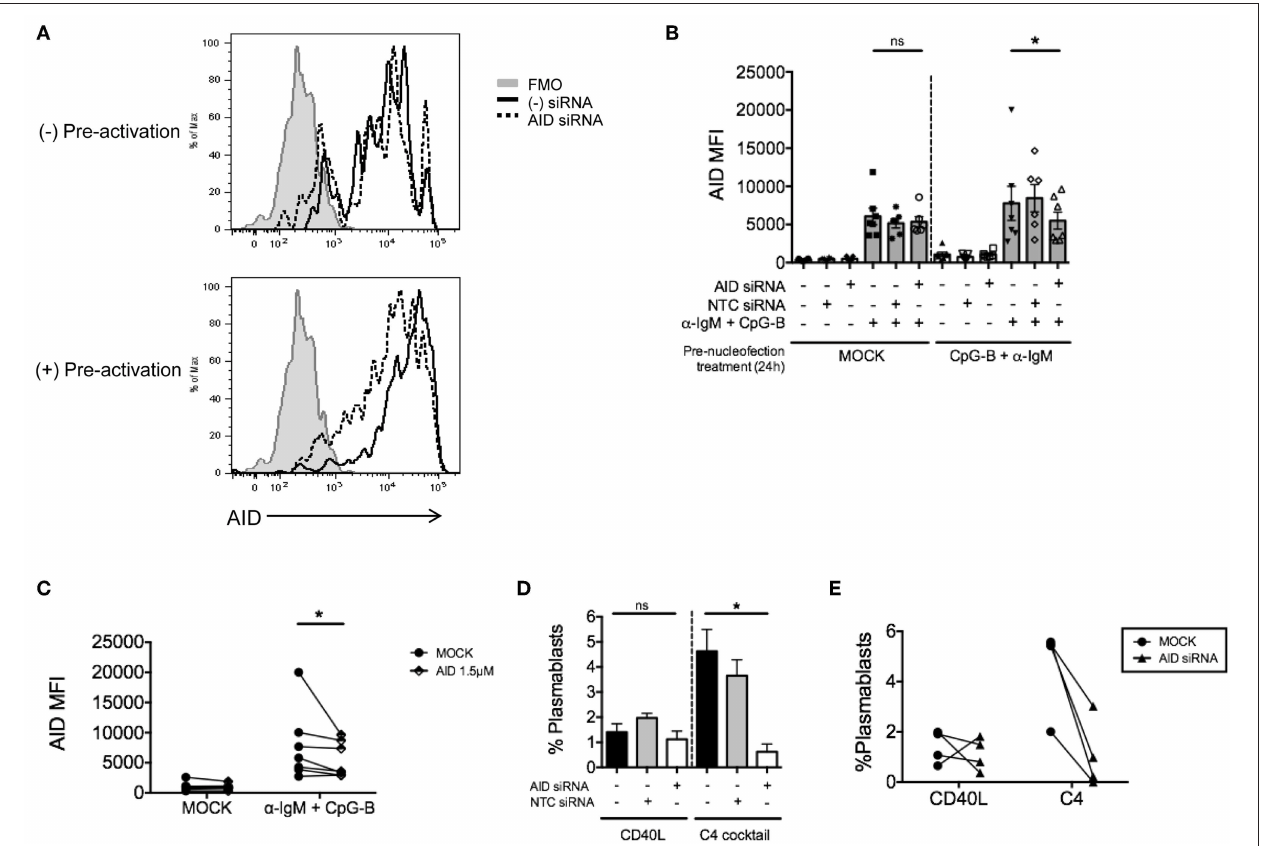
FIGURE 5 | Pre-activation of primary naïve human B cells enhances the effect of AID knockdown. Isolated naïve B cells were cultured for 24h ( + Pre-activation) or without (-Pre-activation) anti-IgM + CpG-B then nucleofected one time with AID or NTC siRNA (1.5 µ M). After 24h resting, cells were re-stimulated with or without anti-IgM + CpG-B for 72h. (A) Representative histogram overlay of AID expression after knockdown in the presence or absence of pre-activation. (B) AID MFI in CD19 + IgD + B cells was determined at 72h post-stimulation ( n = 7). (C) Paired dots show the efficiency of AID knockdown in CD19 + IgD − B cells from matched independent donors in (B) . (D) Following pre-activation and nucleofection with AID or NTC siRNA, cells were in vitro cultured for 7 days with C4 cocktail to induce plasmablast differentiation (CD19 + IgD − CD27 + CD38 + ) ( n = 4). (E) Effect of AID siRNA on % plasmablasts from (D) are shown as paired dots to indicate matched donor effects. Bars represent mean ± SEM. P -values were determined by paired t -test for significance (* p <